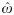
Improving oscillations by increasing the occupancy of all binding sites.Peak frequency ω^ (panel A) and the quality factor Q90% (panel B) as a function of ϵ and λ, for oscillations in the number fluctuations of repressor for the same parameter as Fig 5, but with a0 = 0.15 μM min−1 and g0 = 0.15 min−1.